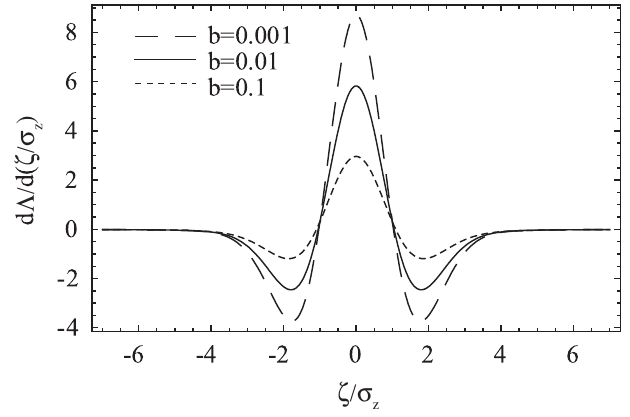
FIG. 2. The function (cid:3) 0 [Eq. (10)] versus (cid:4)=(cid:5) z for b ¼ 0 : 1 (dotted curve), b ¼ 0 : 01 (solid curve), and b ¼ 0 : 001 (dashed